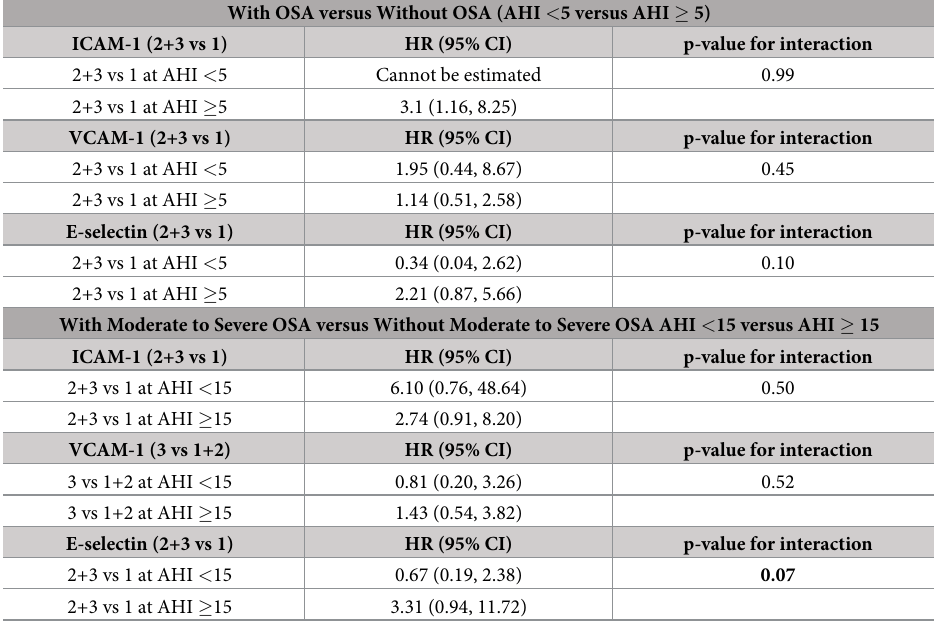
Table 4. Stratified hazard ratios for cardiovascular events by AHI